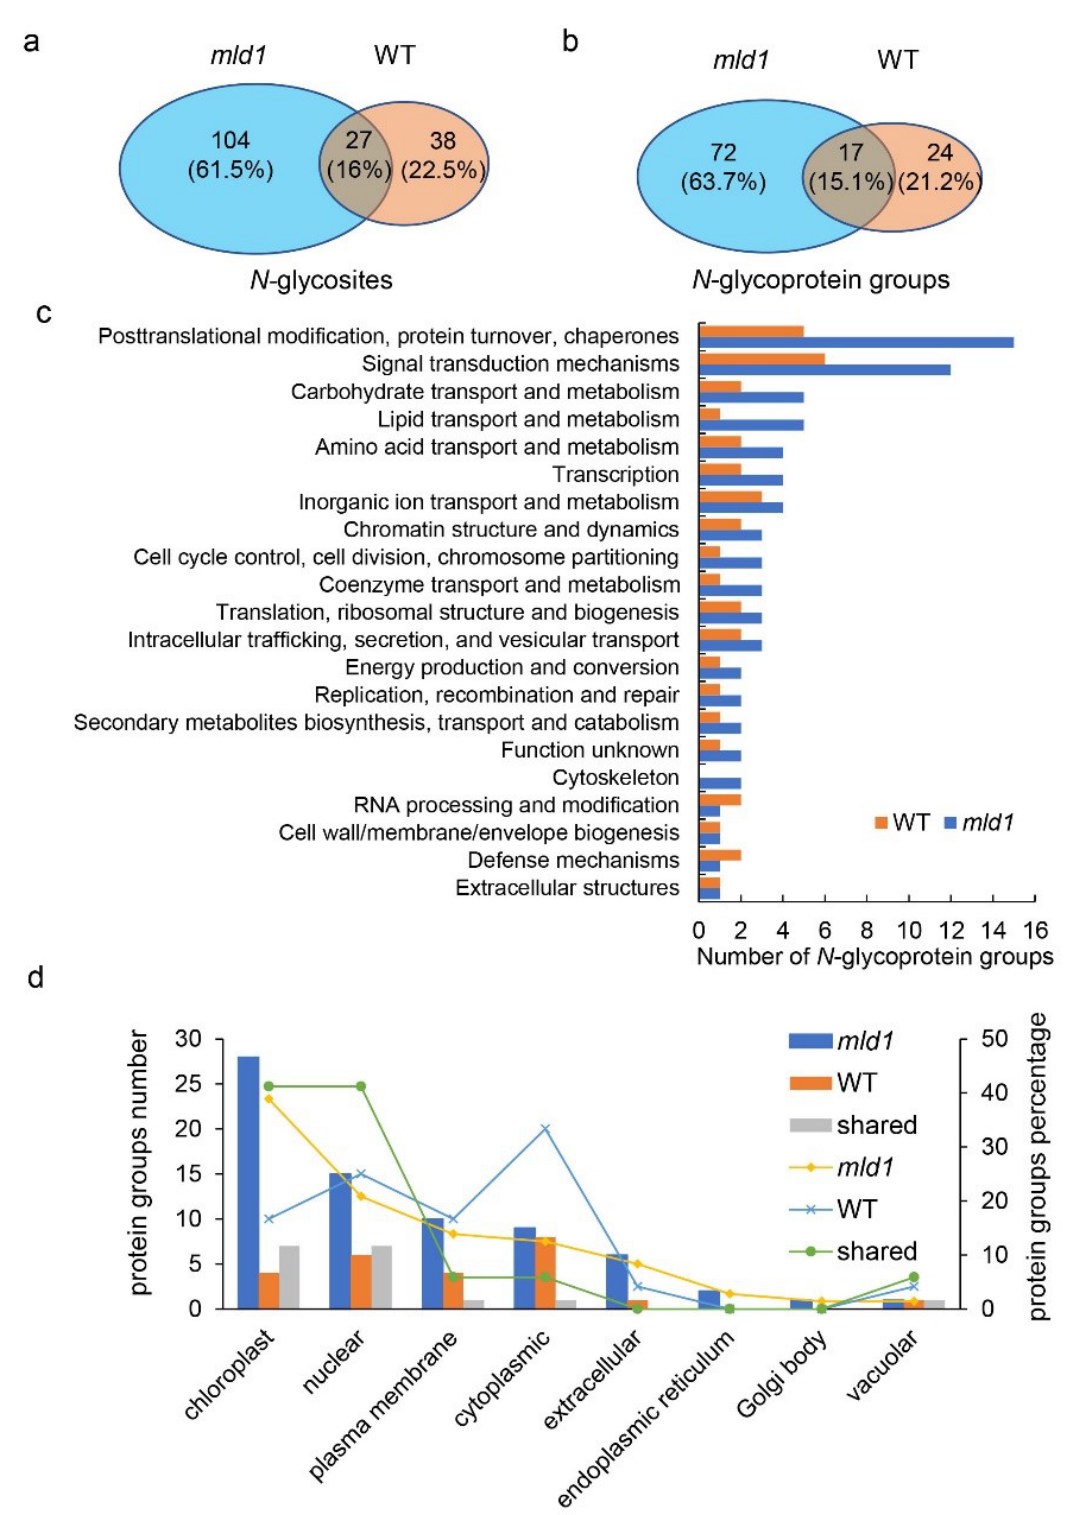
Figure 5. N -Glycoproteome analysis of the wildtype and mld1 mutant. ( a , b ) Overlap of the N -glycosites and N -glycoprotein groups from mld1 and the WT. ( c ) Distribution of N -glycoproteins based on COGs. ( d ) Subcellular location of protein groups.